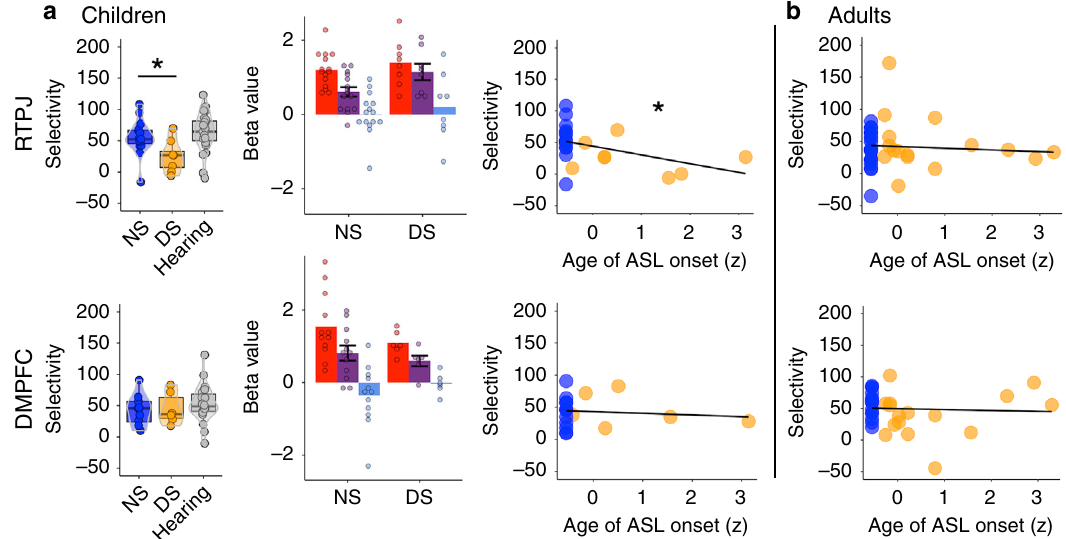
Fig. 3 RTPJ & DMPFC responses to ASL story task. a Standard boxplots (left) show the distribution of selectivity indices in RTPJ (top row) and DMPFC (bottom row) in native signing (NS; blue; RTPJ: n = 15; DMPFC: n = 12 (out of 16)), delayed signing (DS; orange; RTPJ: n = 8; DMPFC: n = 6 (out of 8)), and age-matched neurotypical hearing (gray; n = 28 6 – 10-year old) children, who completed an analogous fMRI story task in English. Center line re fl ects median, box re fl ects interquartile range (IQR), whiskers show fi rst quartile/third quartile − / + 1.5*IQR; dots show individual data points per participant; violin outline shows the distribution of data. Selectivity index was calculated as the average beta estimate to (Mental – Social/Mental – Physical)*100. Asterisk indicates that delayed signers had less selective RTPJ responses than native signers (two-sided non-parametric Mann – Whitney U test; W = 97, CI = [4.3, 53.6], P = 0.02). Bar plots (middle) show mean beta estimates by condition + / − SEM (Mental (red), Social (purple), Physical (blue)) in individually de fi ned RTPJ (top) and DMPFC (bottom) ROIs in children; dots show individual data points per participant. The mental and physical conditions were used for individual ROI de fi nition and are shown for visualization purposes only (and therefore do not have error bars). Scatterplots (right) show the selectivity index for RTPJ and DMPFC in NS (RTPJ: n = 15; DMPFC: n = 12) and DS children (RTPJ: n = 8; DMPFC: n = 6) by Z -scored age of ASL onset ( x - axis). Asterisk indicates a signi fi cant effect of age of ASL onset on RTPJ selectivity among children ( b = − 0.47, t = − 2.3, 95% CI = [ − 0.90, − 0.05], P = 0.03; linear regression controlling for age and motion). b Scatterplots show the selectivity index for RTPJ and DMPFC in adults (RTPJ (top): n = 20